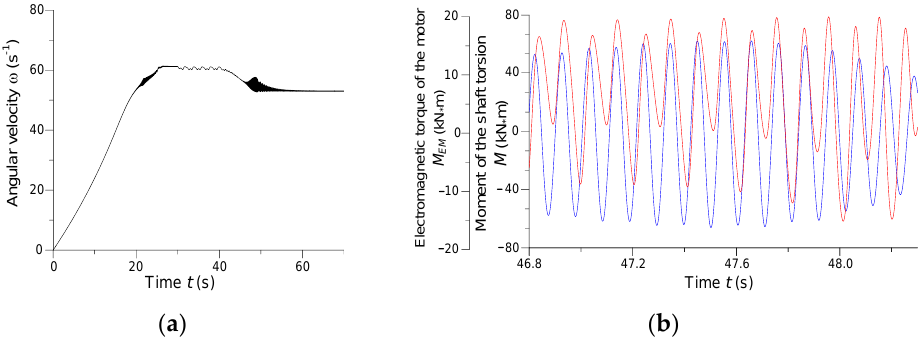
Figure 11. Instantaneous: ( a ) angular velocity of the synchronous drive rotor; and ( b ) moment of torsion in the middle shaft section (blue) and electromagnetic torque of the synchronous drive (red). Instantaneous angular velocity of the synchronous motor is depicted in Figure